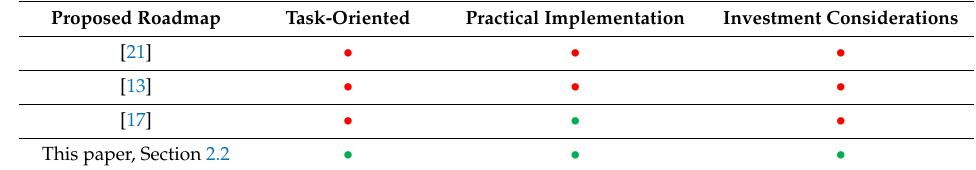
Table 7. Roadmap comparison.